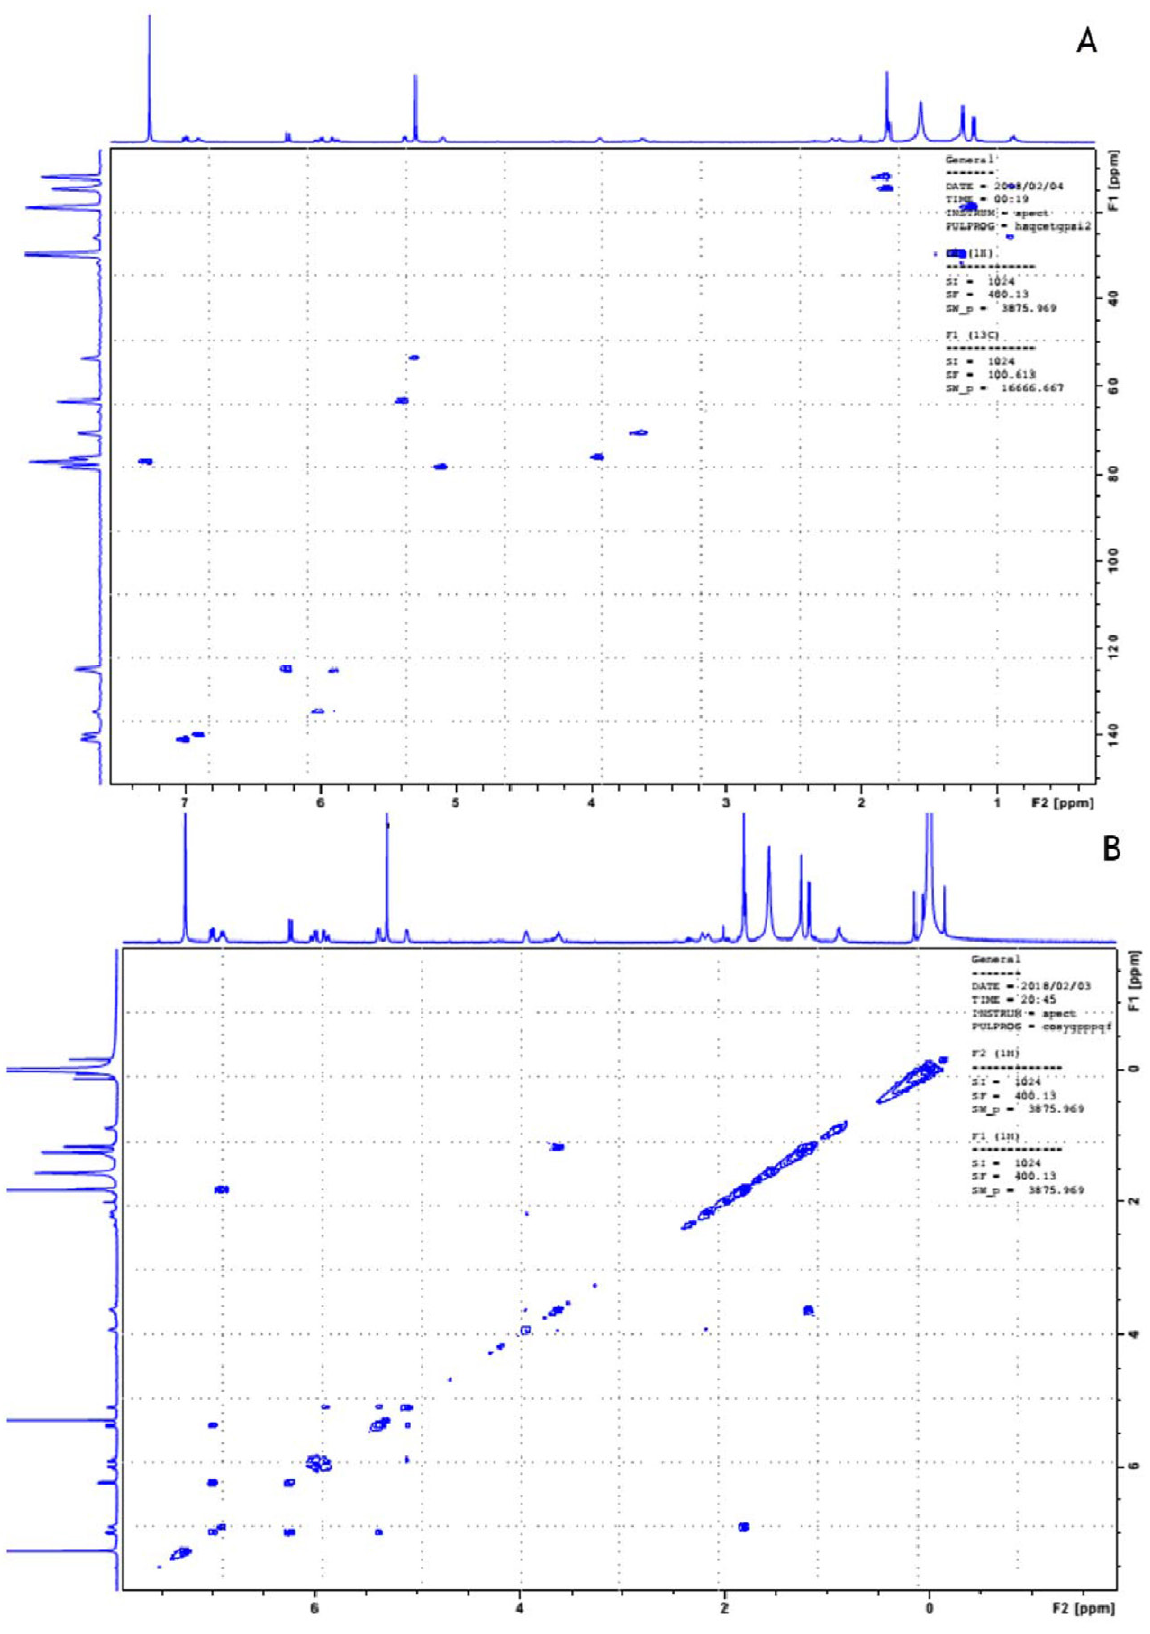
Figure 5. HSQC (A) and COSY (B) spectra of compound